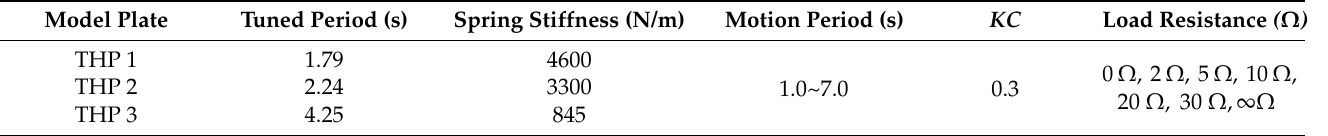
Table 2. The parameters of the THPEH systems in model test.